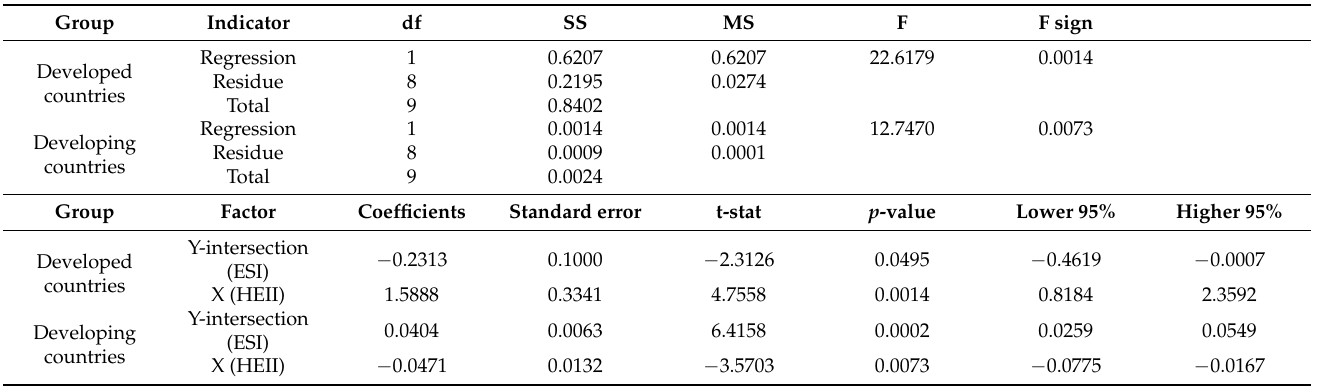
Table 5. Indicators of analysis of variance for the Energy Security